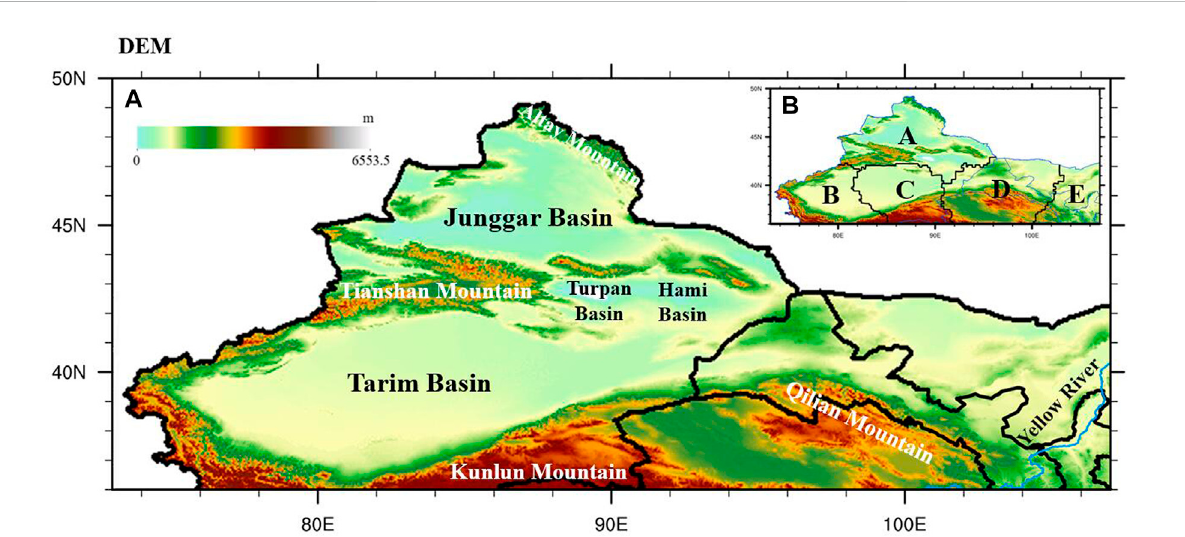
FIGURE 1 TopographyandsubregionsintheANWC.K-meansclusteringdividestheANWCinto fi veregions:A,B,C,D,andE.Thebottomlayerofthemap is topographical. The black lines in (A) are provincial boundaries, and the blue line is a river. The black lines in (B) are the dividing lines between regions, and the blue lines indicate provincial and national